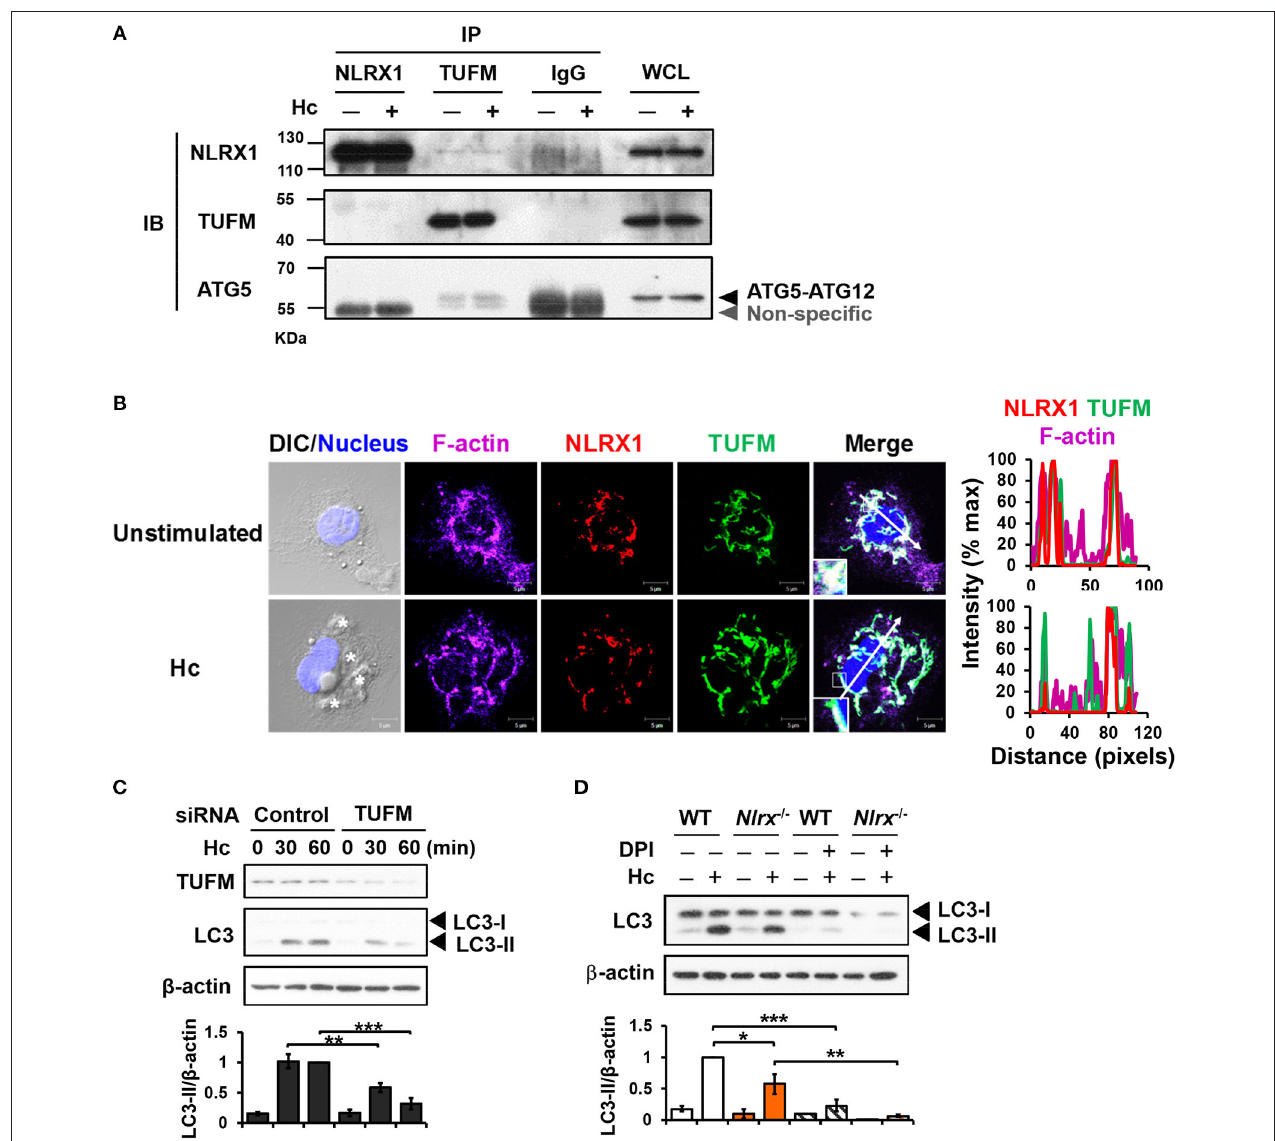
FIGURE 6 | NLRX1 promotes LAP through association with TUFM-ATG5-ATG12 complex. (A) Macrophages from WT mice were stimulated with or without H. capsulatum . Cell lysates were collected at 30min after stimulation and used for immunoprecipitation with anti-NLRX1, anti-TUFM or isotype control antibodies, followed by immunoblotting with indicated antibodies. IP, IB, and WCL denote immunoprecipitation, immunoblotting, and whole-cell lysate, respectively. (B) Macrophages were stimulated with or without H. capsulatum (MOI = 5) for 60min. Cells were fixed and stained for NLRX1 (red), TUFM (green), F-actin (violet), and nucleus compartment (blue). Cells were viewed under confocal microscope. Asterisks in the DIC/Nucleus field point to H. capsulatum yeasts. Box areas are shown at higher magnification in the bottom left corner of the corresponding image. The intensity of different fluorochromes along the white arrow in the merged image is shown as histogram on the right. (C) Macrophages from WT mice were transfected with control siRNA or siRNA against TUFM (50nM) for 72h. Cells were then stimulated with or without (0min) H. capsulatum (MOI = 5) for 30 and 60min. After stimulation, cell lysates were collected and assessed by Western blotting. (D) Macrophages from WT and Nlrx1 − / − mice were treated with or without DPI (5 µ M) for 1h prior to stimulation with H. capsulatum (MOI = 5). Cell lysates were collected after 1h of stimulation and analyzed by Western blotting. Data shown in the lower panel of (C,D) are relative intensity of LC3-II normalized against the corresponding β -actin, mean ± SEM are shown ( n = 3). * p ≤ 0.05, ** p ≤ 0.01, *** p ≤ 0.001 [ANOVA with Bonferroni’s multiple comparisons post-hoc test (C,D) ].